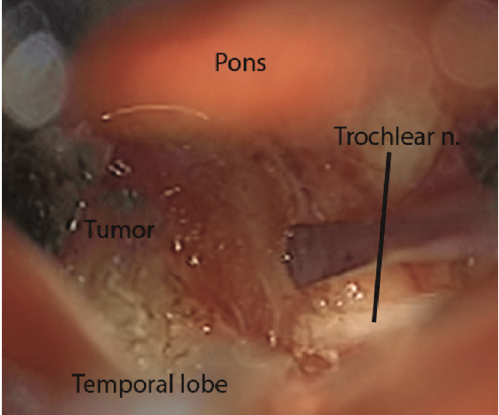
Figure 2: The trochlear nerve entering directly into the visualized